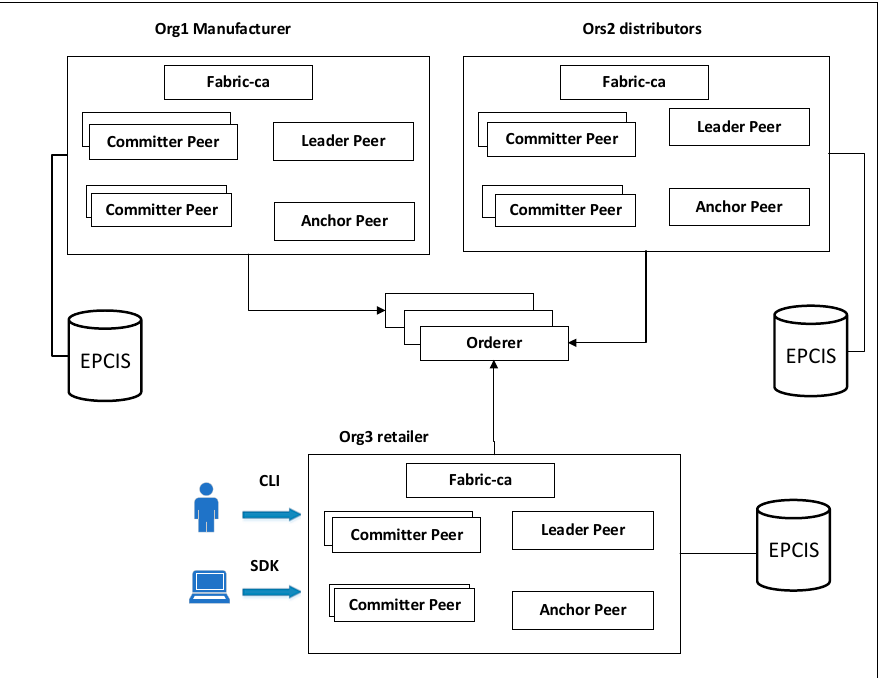
Figure 4. Network deployment scheme.